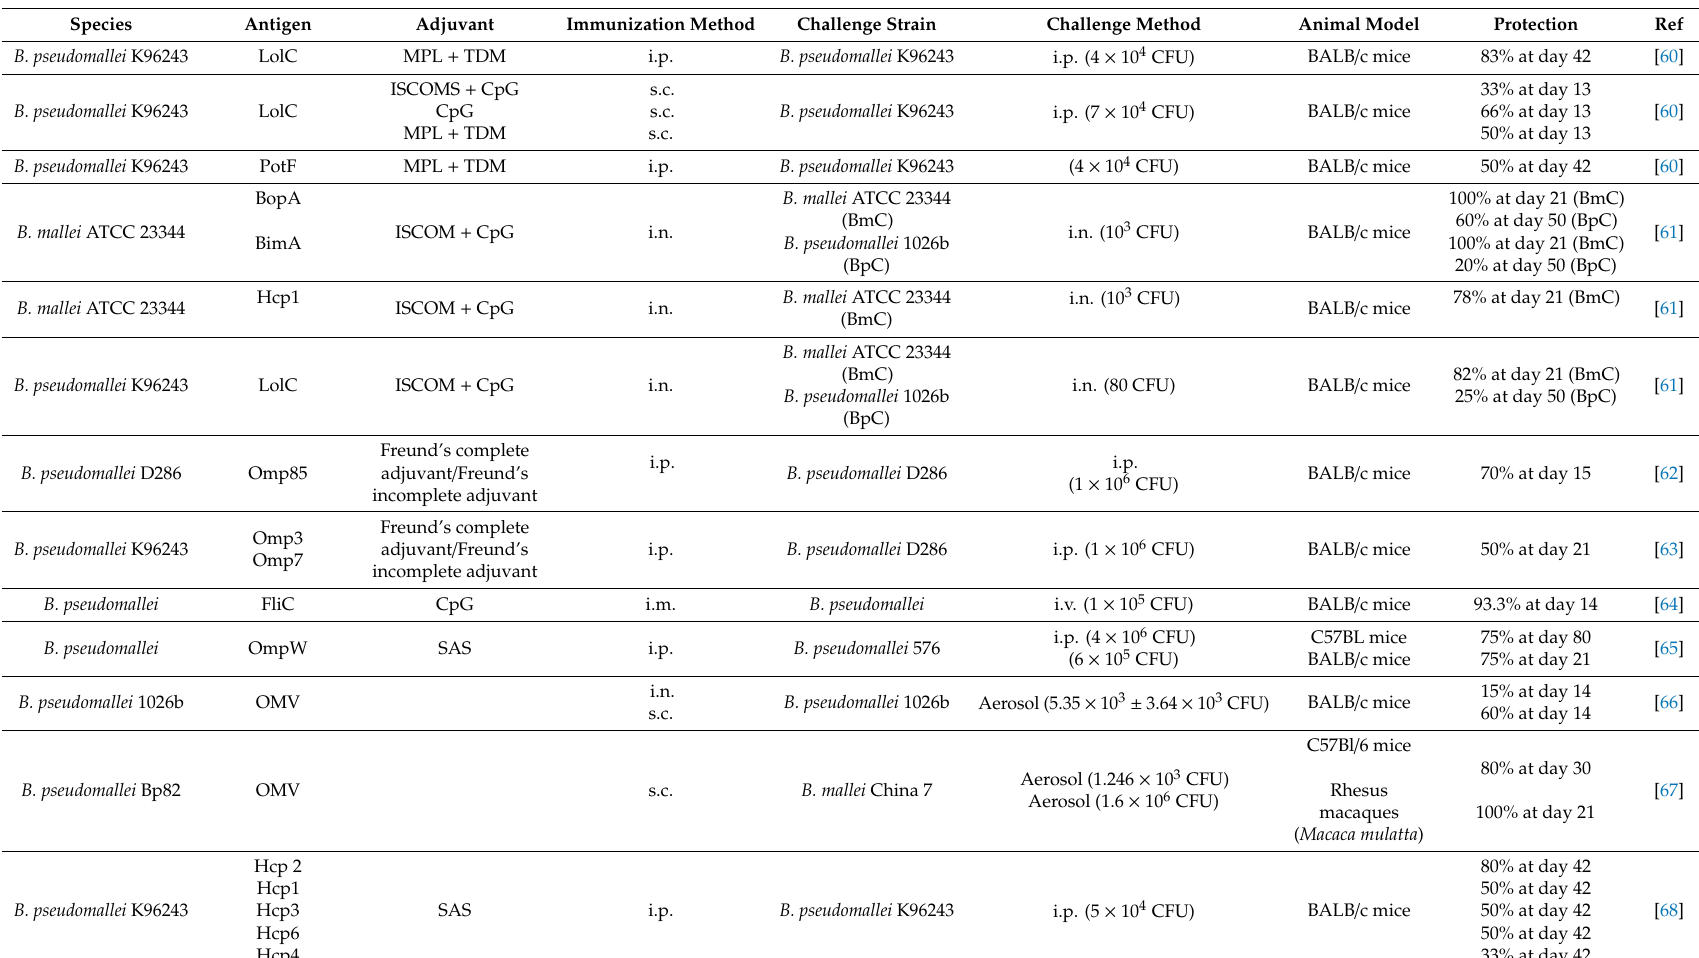
Table 3. Subunit vaccines a